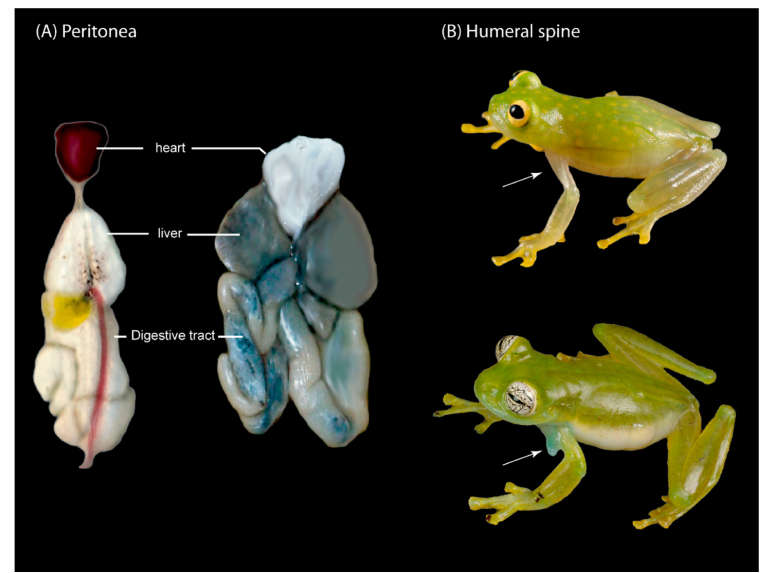
Figure 13. Peritonea and humeral spines in Centrolenidae. ( A , Left ): Pericardium lacking iridophores, hepatic, and visceral peritonea with iridophores ( Hyalinobatrachium aureoguttatum ). ( A , Right ): Pericardium with iridophores, hepatic, and visceral peritonea lacking iridophores ( Centrolene buckleyi ). ( B , Top ): Absence of humeral spine ( H . fleischmanni ). ( B , Bottom ): Presence of humeral spine in males ( Espadarana callistomma ). Figure modified from Guayasamin et al. [1]. Diversity 2020 , 12 , x FOR PEER REVIEW